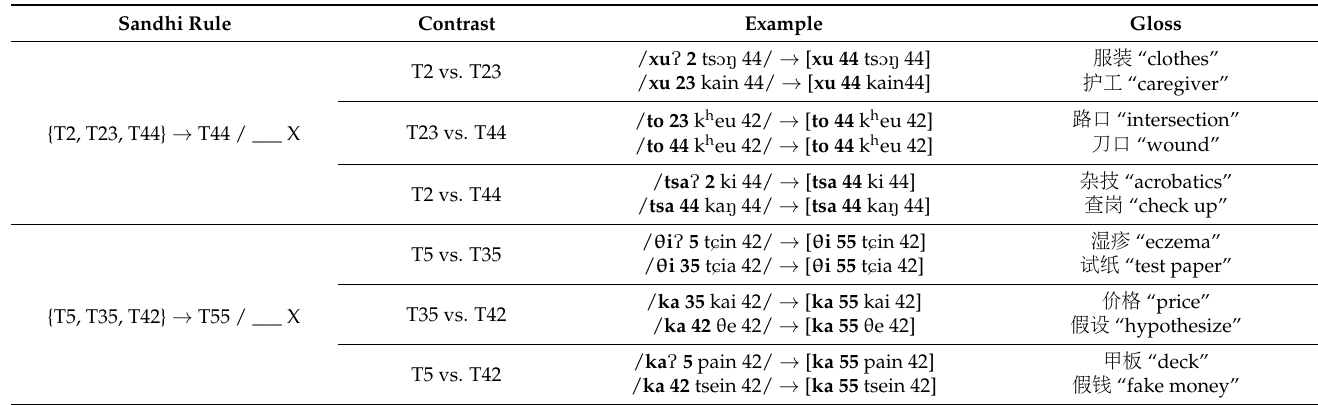
Table 5. Stimuli of neutralized sandhi tones in compounds for the production experiment (target syllable in